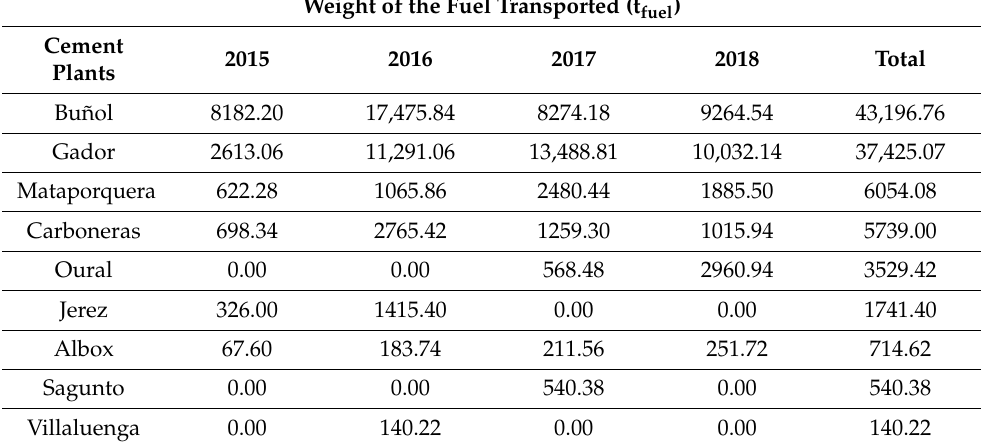
Table 5. Weight of the fuel